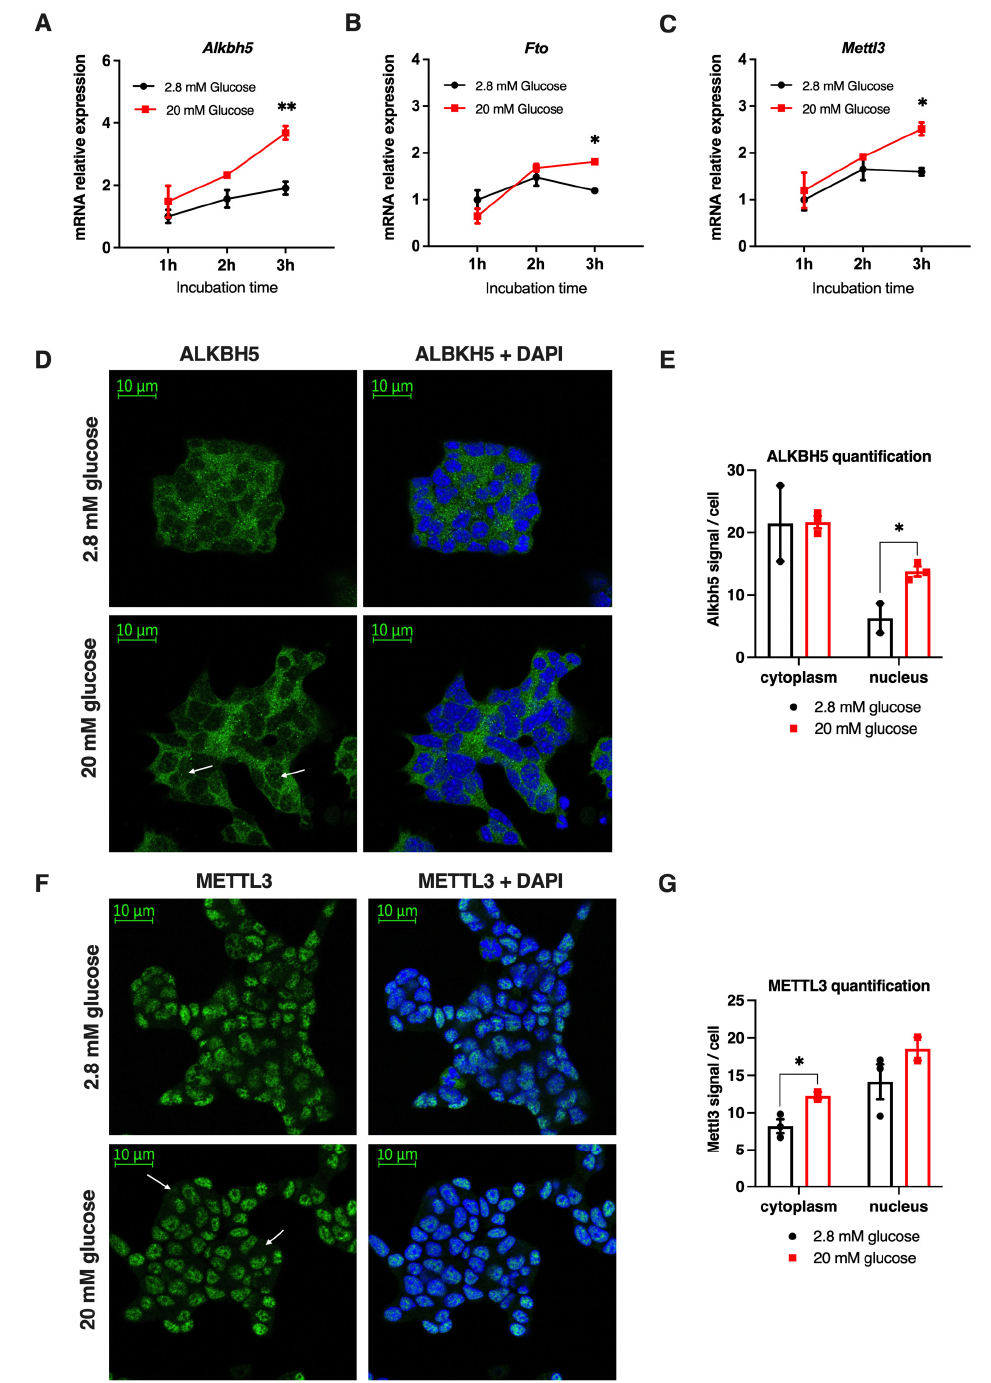
Figure 3. mRNA expression and protein localization of m 6 A reader and erasers after glucose treat- ment. ( A – C ) mRNA expression of Alkbh5 ( A ), Fto ( B ) and Mettl3 ( C ) were quantified in Min6 cells by RT-qPCR after 1, 2 or 3 h of 2.8 or 20 mM glucose treatment ( n = 3). Immunofluorescence of ALKBH5 in Min6 cells after 3 h of 2.8 or 20 mM glucose treatment ( D ) and its quantification using ImageJ (( E ), n = 3). Immunofluorescence of METTL3 in Min6 cells after a 3 h treatment with 2.8 or 20 mM glucose treatment ( F ) and its quantification (( G ), n = 3). Data were analyzed by two-way ANOVA with Bonferroni’s correction for multiple comparisons multiple t -tests ( A – C ) or multiple unpaired t -tests ( E , G ). * p < 0.05, ** p <